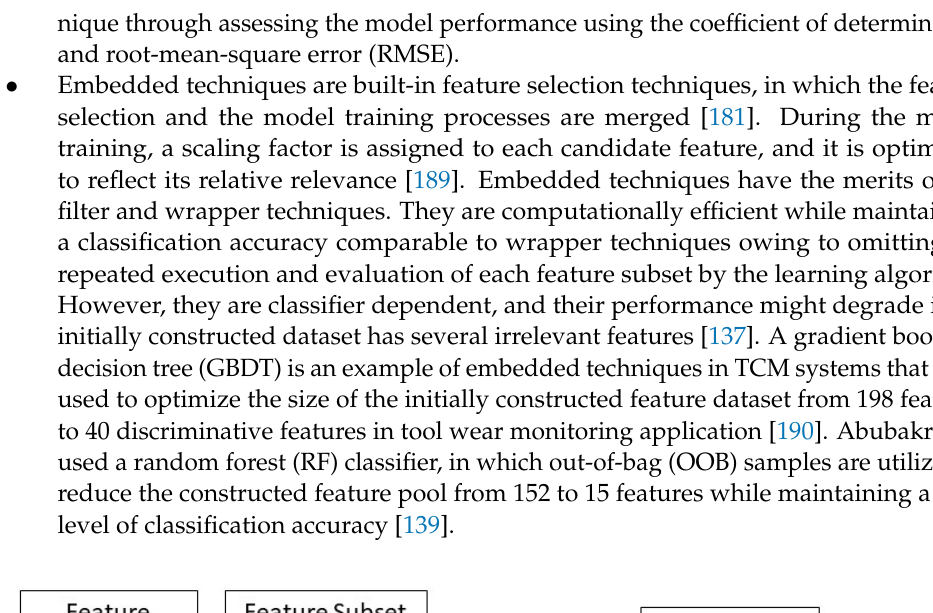
Figure 6. Filter techniques framework used for feature selection.